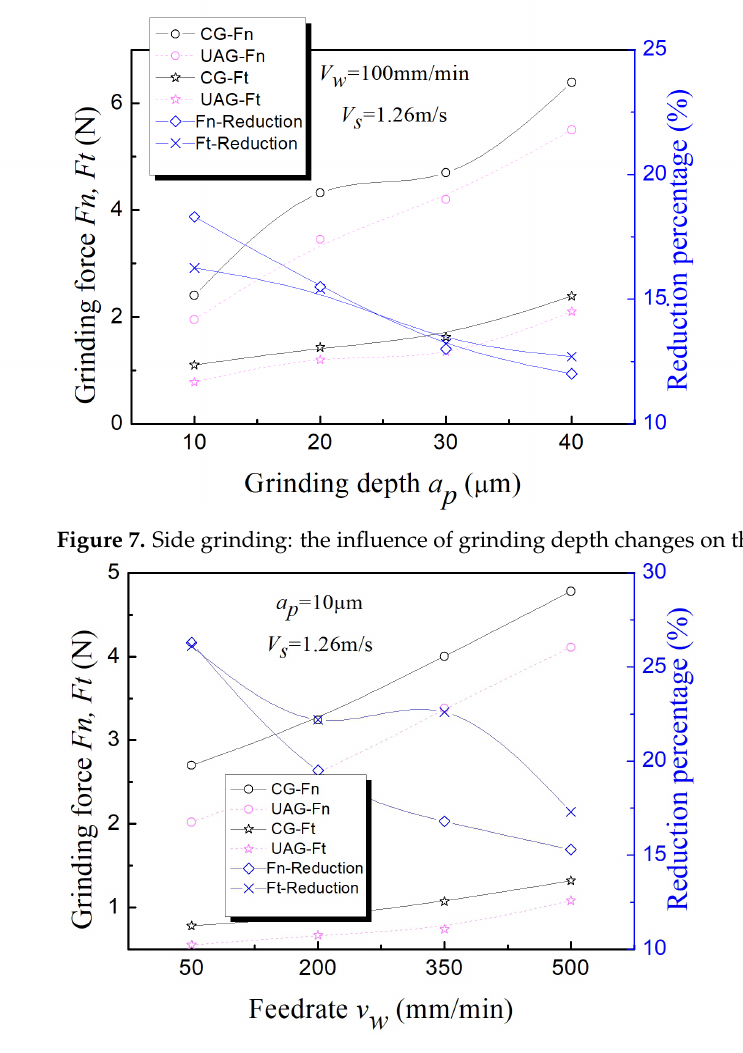
Figure 8. Side grinding: the influence of feed speed changes on the grinding